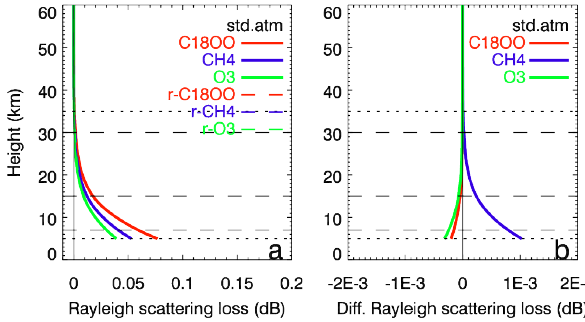
Fig. 8. Rayleigh scattering loss (a) and differential Rayleigh scattering loss (b) for three representative channel pairs with different spectral spacings, for FASCODE STD atmosphere conditions. The layout of the panels is the same as in Fig. 7 (the x-axis ranges are smaller).